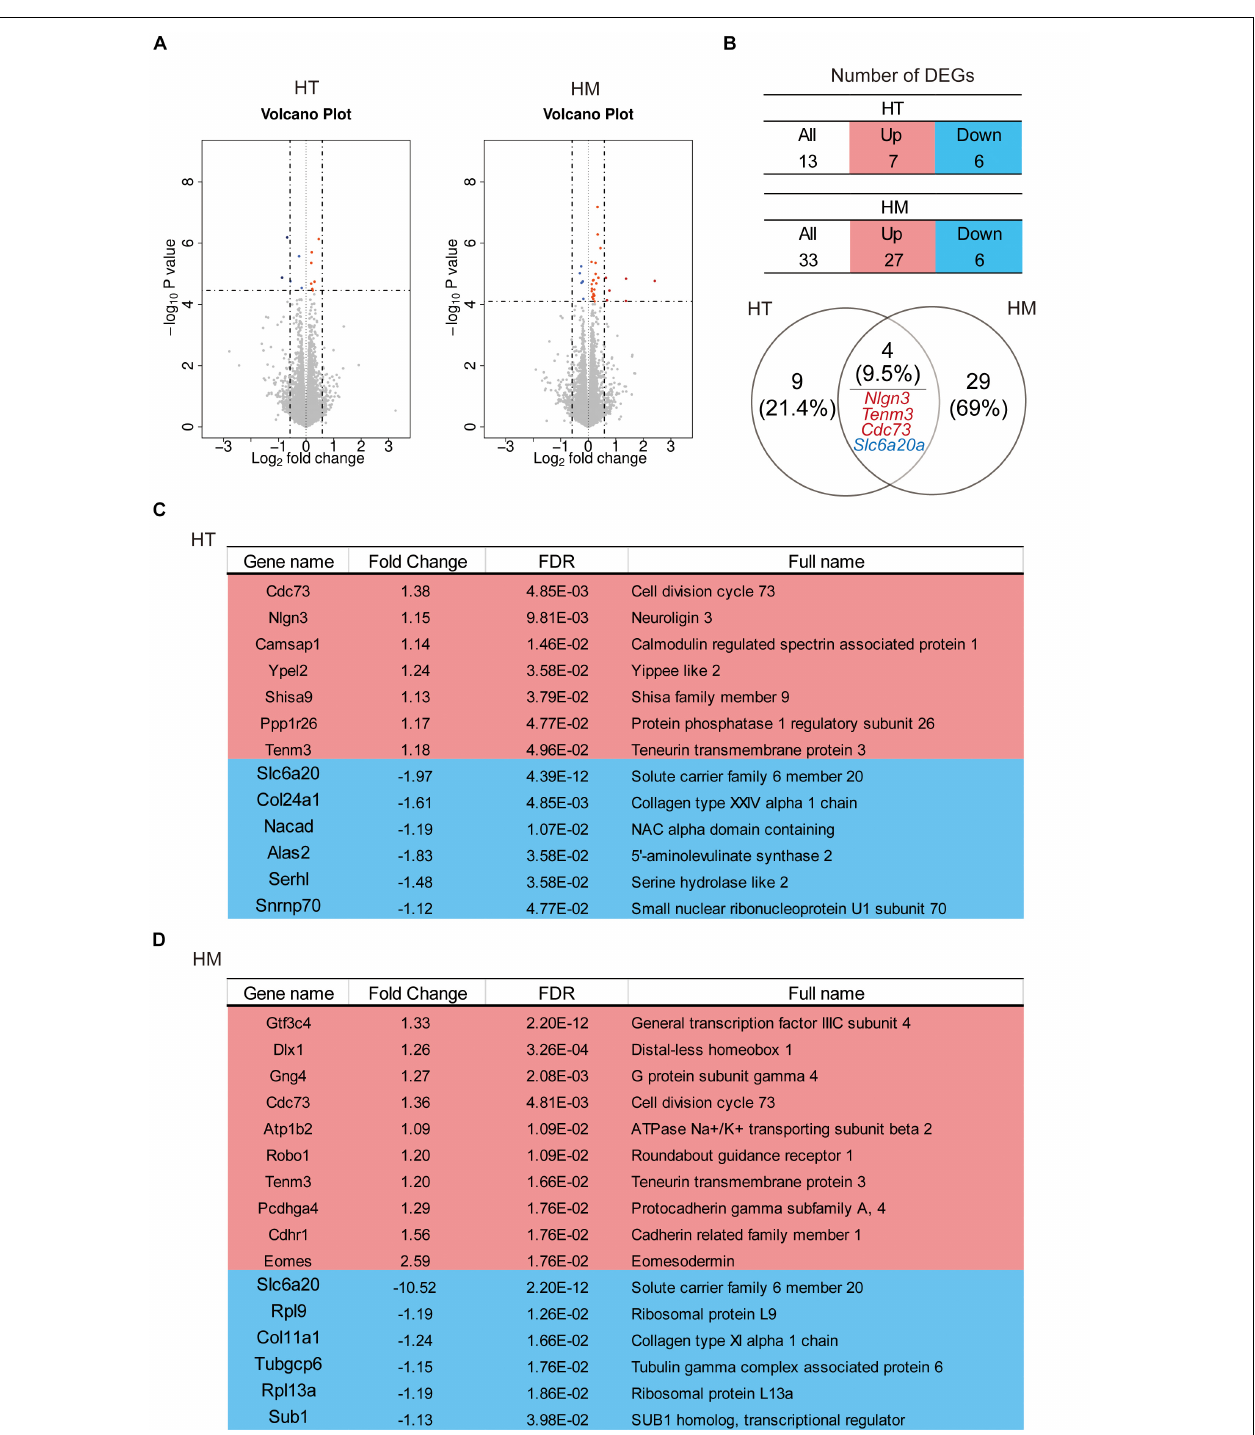
FIGURE 4 | Differentially expressed genes (DEGs) in Slc6a20a + / − and Slc6a20a − / − mice. (A) Volcano plot for DEGs from Slc6a20a + / − and Slc6a20a − / − mice ( ∼ P120). ( n = 4 mice for WT-HT, HT, WT-HM, and HM; dotted lines indicate adjusted p -value < 0.05 or | FC| > 1.5; DEGs were defined by adjusted p-values but not fold changes). See Supplementary Table 2 for raw RNA-seq results. (B) Summary tables showing the numbers of up- and downregulated DEGs, and Venn diagrams showing the overlap between DEGs from Slc6a20a + / − and Slc6a20a − / − mice. Upregulated, overlapped DEGs ( Nlgn3 /neuroligin-3, Tenm3 /teneurin-3, and Cdc73 ) and downregulated, overlapped DEGs ( Slc6a20a ) are indicated in red and blue colors, respectively. (C,D) Lists of all significantly up- and downregulated DEGs from Slc6a20a + / − and Slc6a20a − / − mice; only the top 10 upregulated DEGs out of 27 are shown for Slc6a20a − / − mice to save space (see Supplementary Table 3 for further